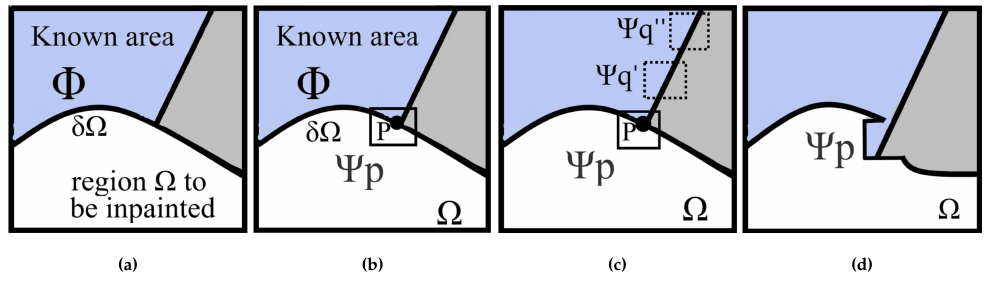
Figure 2. Structure propagation by known area texture synthesis. ( a ) Input. ( b ) Determine the point to be repaired. ( c ) Find the best matching block. ( d ) Fill the neighborhood to be